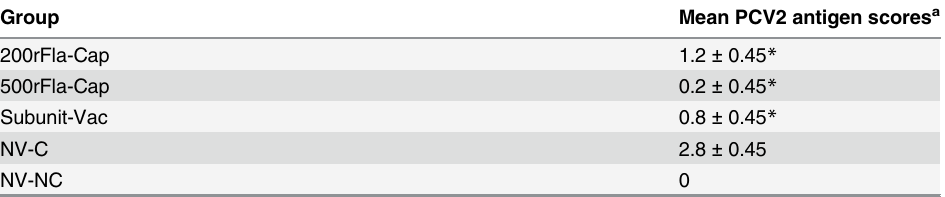
a Asterisks ( * ) within columns represent signi fi cantly difference of mean viral antigen scores between the rFla-Cap- or Subunit-Vac-vaccinated and non-vaccinated PCV2-challenged pigs after challenge ( P < 0.05). The data show the mean scores of fi ve pigs in each group from one of two independent